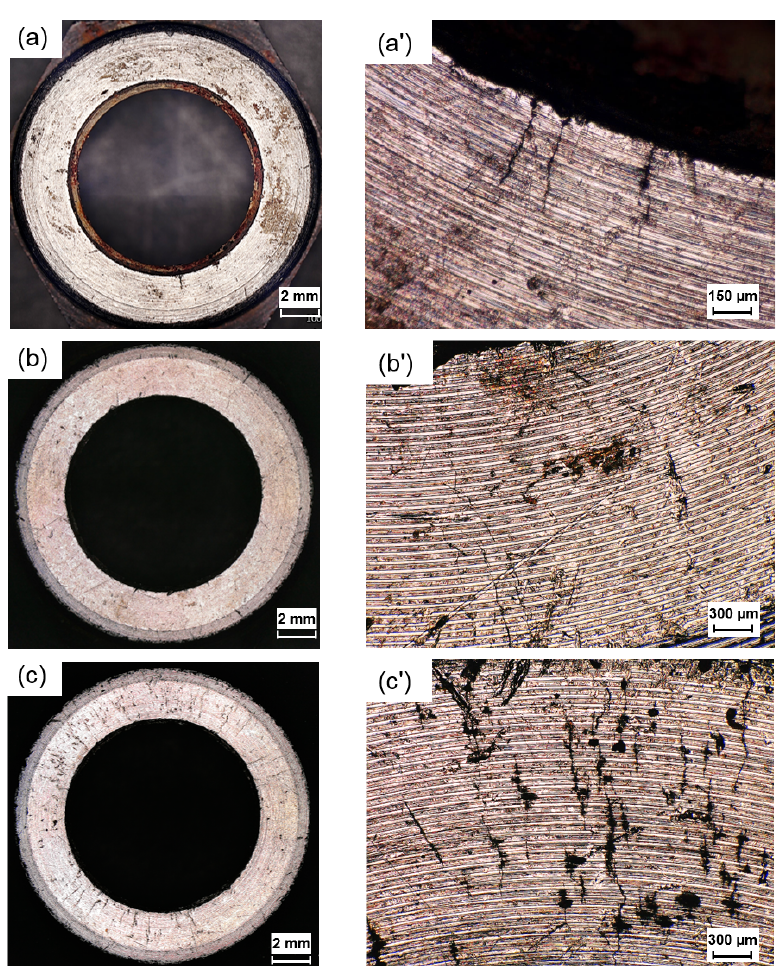
Figure 3. Macro- and microscale plan-view images of stress–corrosion-tested AISI316L nuts, machined by different tools. ( a , a ’) FT1. ( b , b ’) FT2. ( c , c ’)